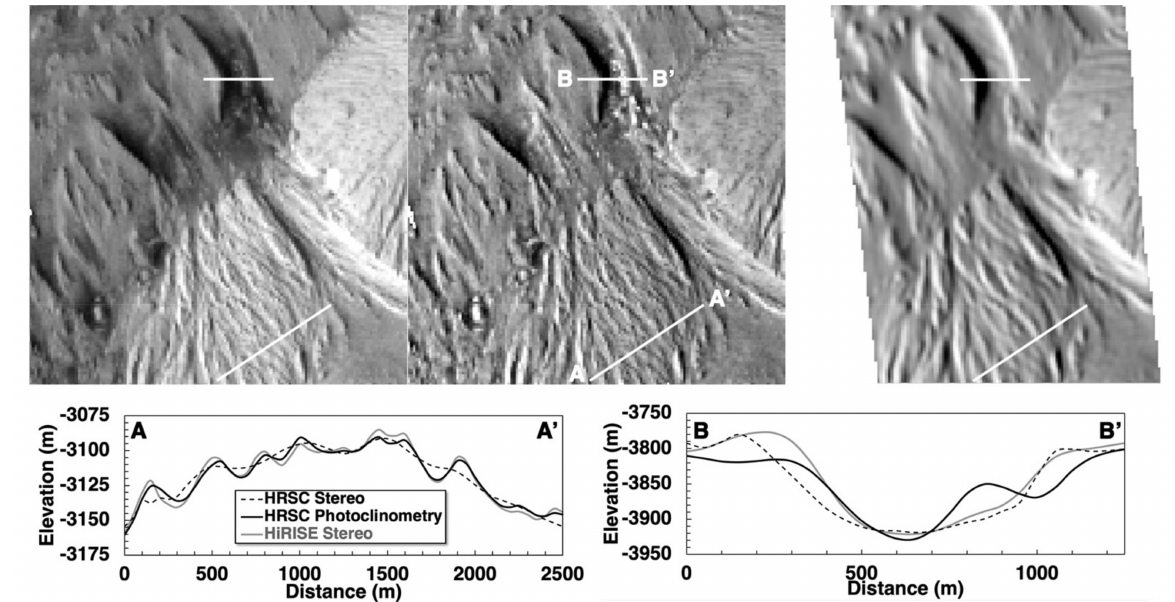
Figure 11. DTM profiles across features without (A-A’) and with (B-B’) uncorrected albedo artifacts. Profile locations are shown on (left to right) HRSC orthoimage, HRSC image after correcting for albedo variations resolved by stereo DTM, and HiRISE shaded relief (cf. Figure